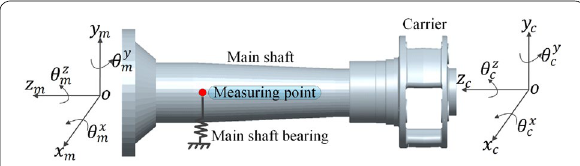
Figure 3 Structure diagram of main shaft and